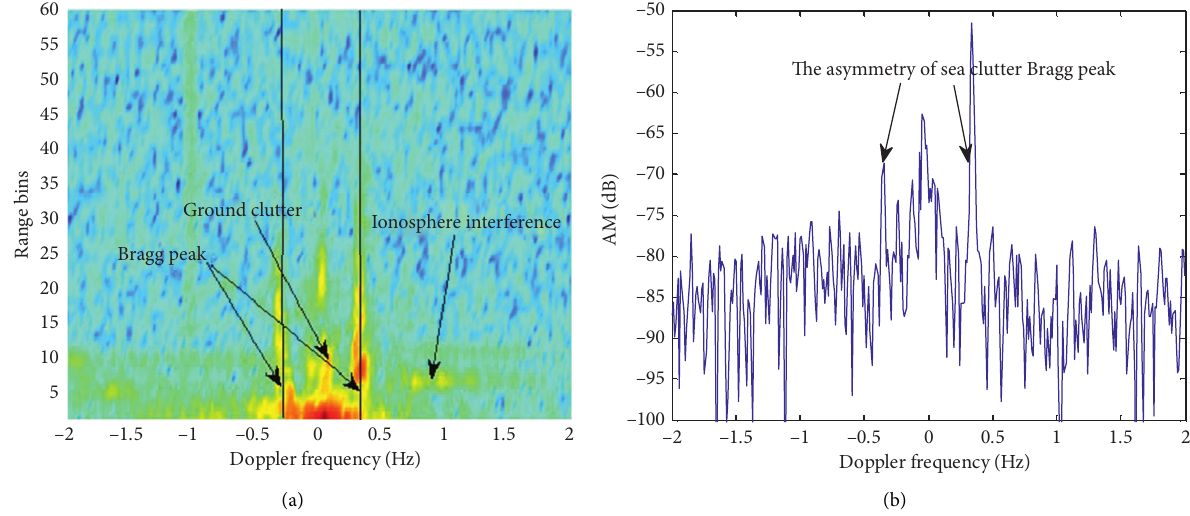
Figure 4: The range-Doppler spectrum and asymmetry of the measured sea clutter in HF sky-surface wave radar. (a) Range-Doppler spectrum of actual sea clutter. (b) The asymmetry of actual sea clutter